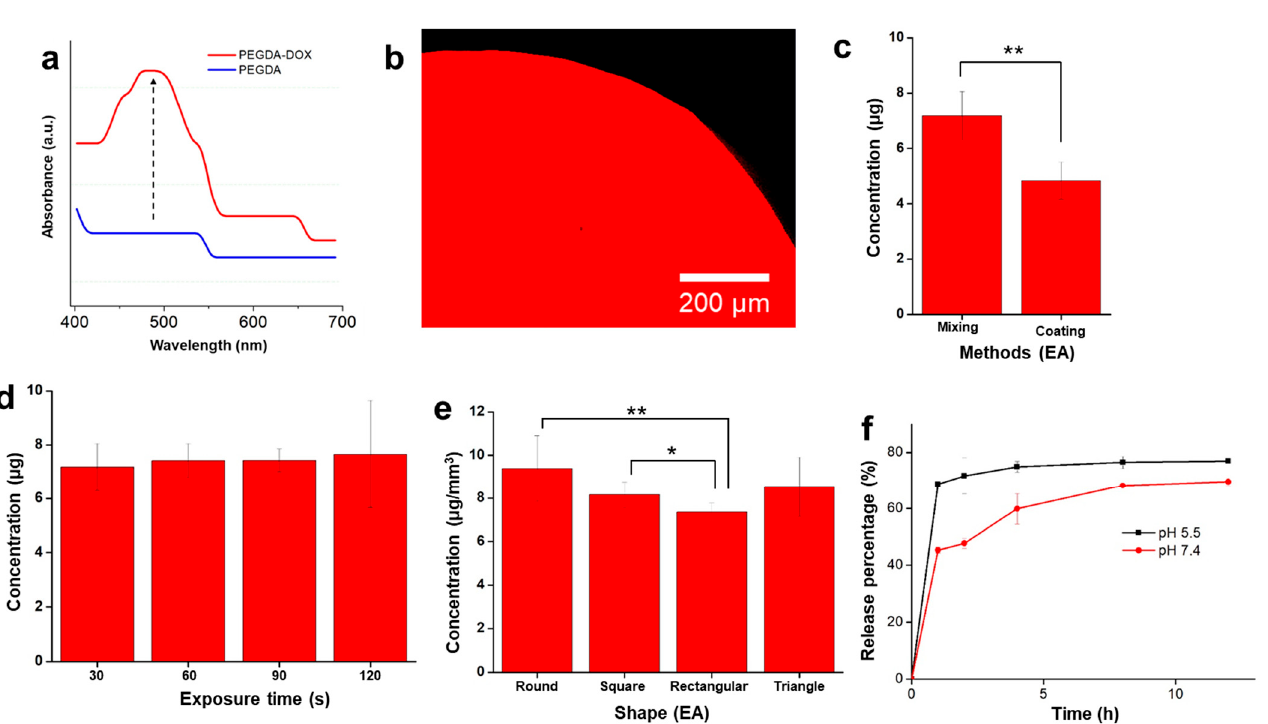
Figure 4. ( a ) Absorbance measurements for doxorubicin only and as solid drugs; ( b ) confocal image that shows the doxorubicin under fluorescence; ( c ) comparison of the concentration of the mixing and coating method (** p < 0.01, Student’s t -test; n = 3); ( d ) effect of exposure time on drug concentration; ( e ) the effect of shape on drug concentration (** p < 0.01 and * p < 0.05, Student’s t -test; n = 3); ( f ) drug release profile at two different pH values.